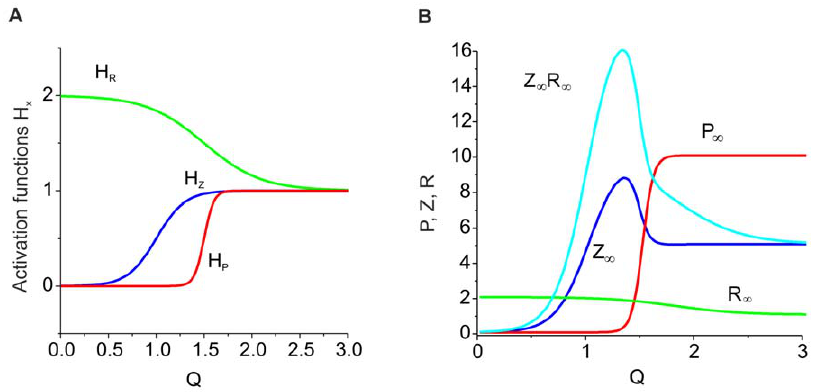
Figure 4. Activation kinetics for the concentrations of ECM molecules, proteases and ECM receptors, respectively. A. Activation functions for model (9). Parameter values: z 0 =p 0 =0, z 1 =p 1 =1, r 0 =2, r 1 =1, h z =1 k z =0.15, h p =1.5, k p =0.05, h r =1.8, and k r =0.1 . B. Steady state distribution profiles for Z ‘ , P ‘ , and R ‘ are shown by solid curves. The dashed curve illustrates the steady state values of Z ‘ R ‘ regulating the synaptic weights (see Eqs. (10)). Parameter values: z 0 =p 0 =0, z 1 =p 1 =1, r 0 =2, r 1 =1, h z =1,k z =0.15, h p =1.5, k p =0.05, h r =1.8, k r =0.1, a z =0.001 msec 2 1 ,